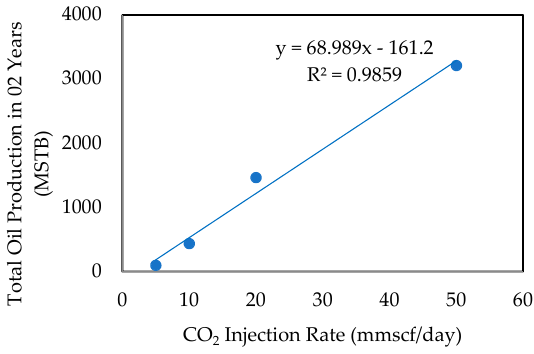
Figure 7. Variation of oil production with CO 2 injection rate.